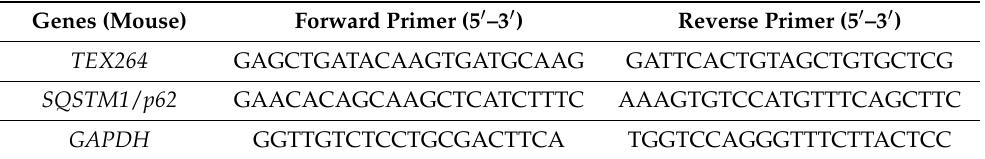
Table 1. Primer sequences for real-time